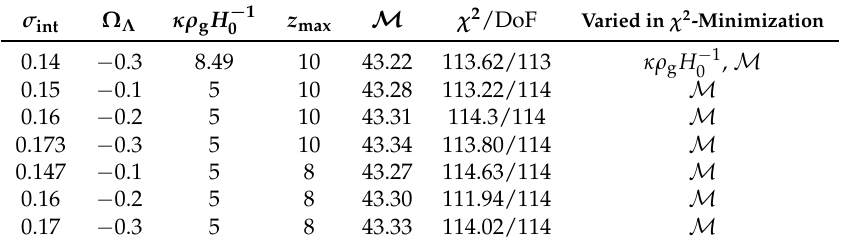
Table 3. Different plausible models in QSSC which provide χ 2 /DoF ≈ 1 for suitably chosen σ int to fit 115 SNeIa from Astier et al. [15]. The parameters z max , Ω Λ ( < 0), κ (measured in the units of 10 5 cm 2